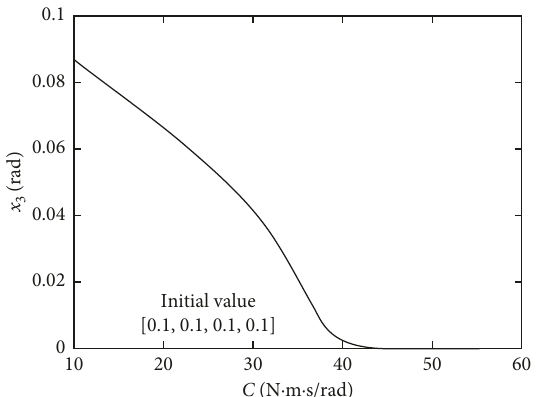
Figure 3: The torsional vibration amplitude curve with the damping C .